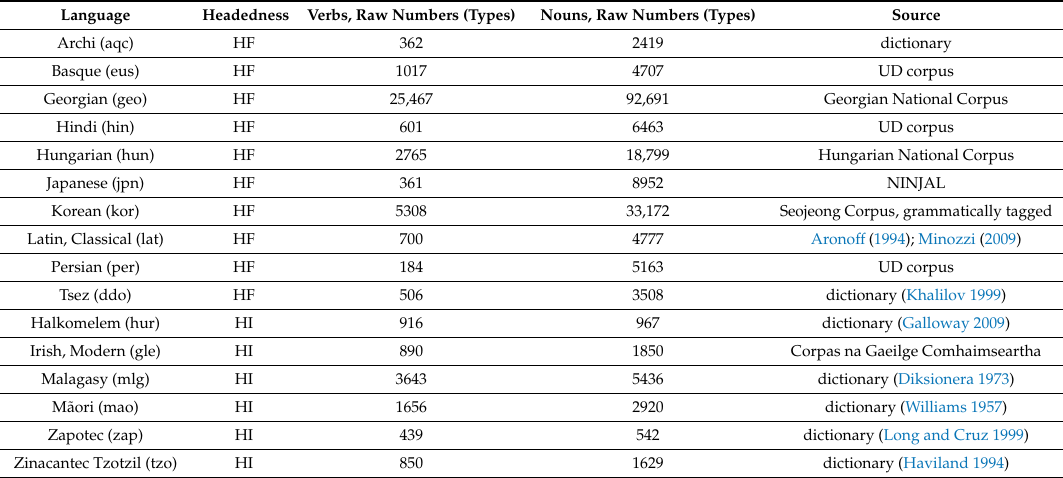
Table 3. Verbs and nouns across languages of the head-final (HF) and head-initial (HI) type.